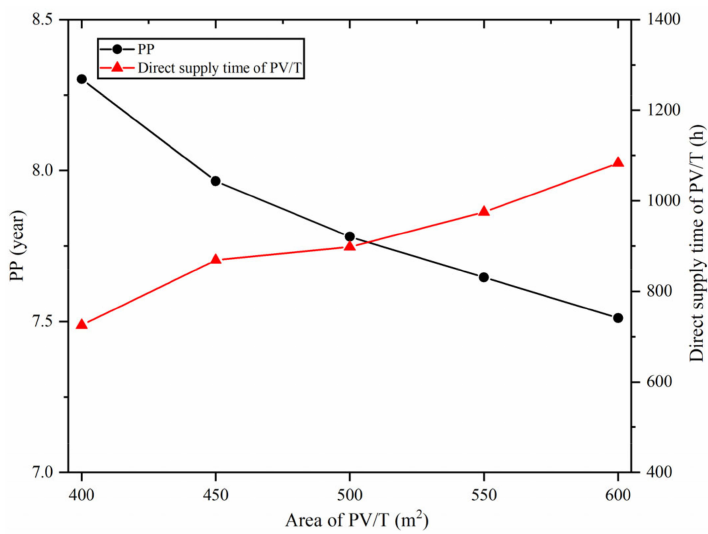
Figure 21. Variation between PP and direct supply time with different area of